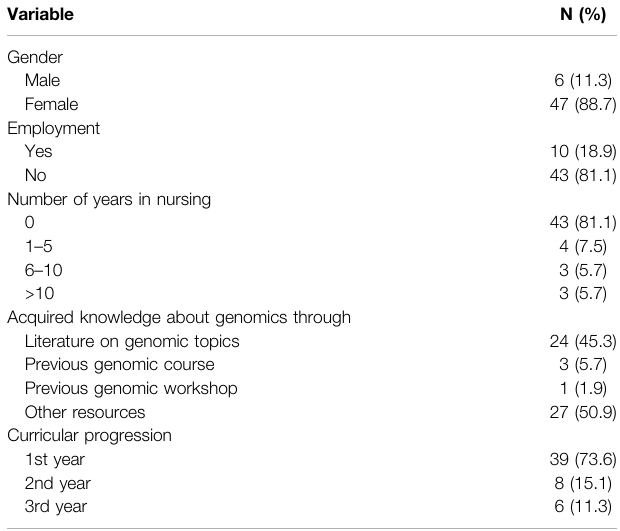
TABLE 1 | Characteristics of the participants ( n (cid:1)